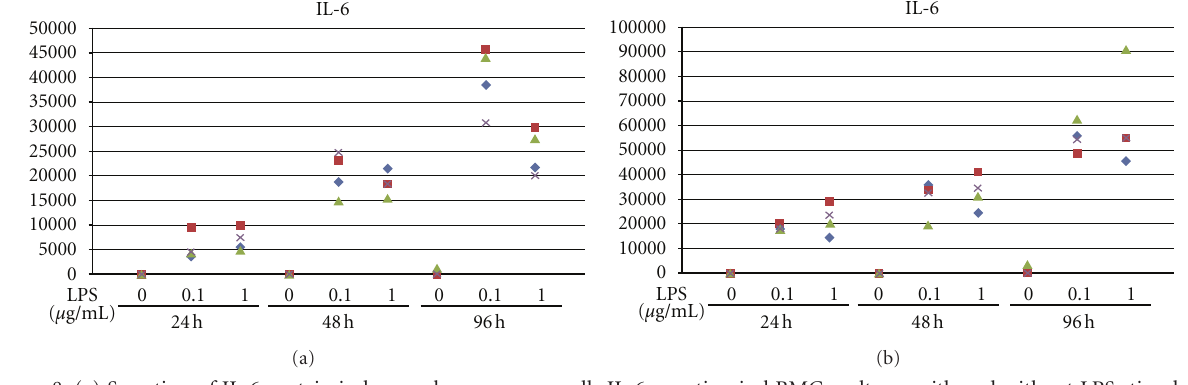
Figure 8: (a) Secretion of IL-6 protein in human bone marrow cells IL-6 secretion in hBMCs cultures with and without LPS stimulation for 24, 48, and 96 hours. LPS concentrations were 0 μ g/mL, 0.1 μ g/mL or 1 μ g/mL. The amount of IL-6 in cell-free culture supernatants was analyzed by ELISA. (b) secretion of IL-6 protein in human gingival fibroblasts Secretion of IL-6 in hGFs with or without LPS stimulation for 24, 48, and 96 hours. LPS concentrations were 0 μ g/mL, 0.1 μ g/mL or 1 μ g/mL. The amount of IL-6 in cell-free culture supernatants was analyzed by